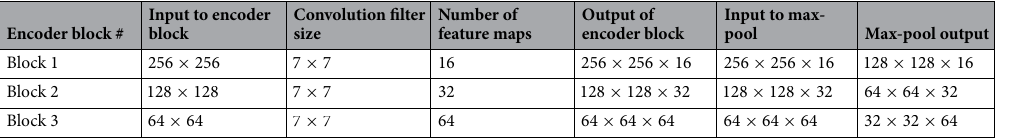
Table 2. Details of all encoder blocks and corresponding max-pool layer output.